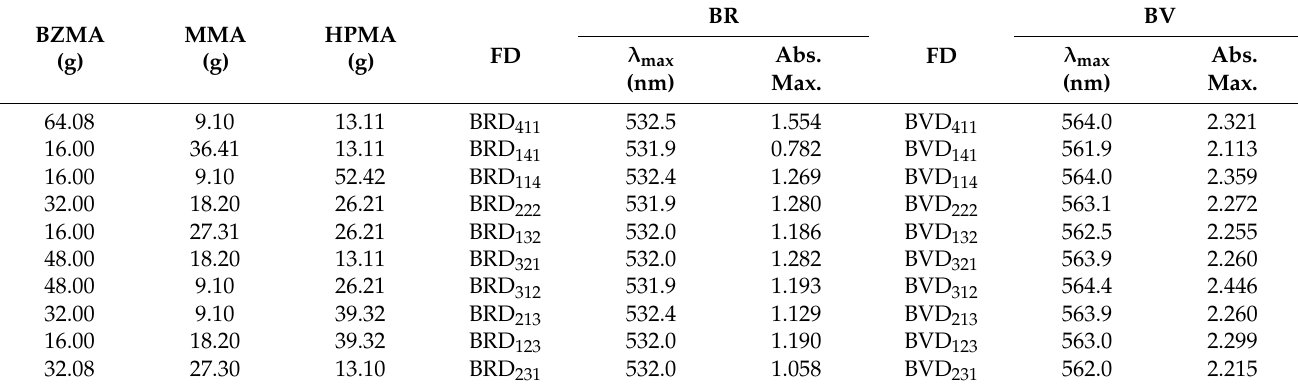
‘FD’ represents fluorescent dispersions, ‘D’ represents dispersion where the suffix numbers represent the moles ratio of the monomer units of BZMA, MMA, and HPMA respectively. The weights given in ‘g’ are proportional to the corresponding moles ratio given in the Table, Figure